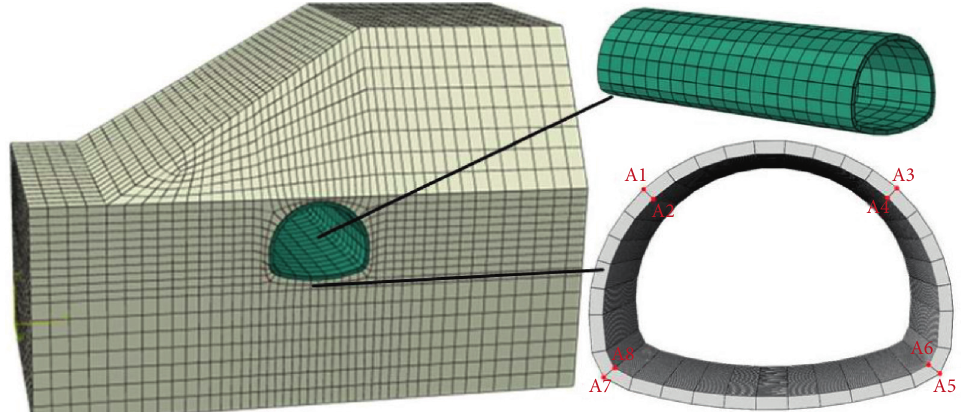
Figure 13: 3D bias